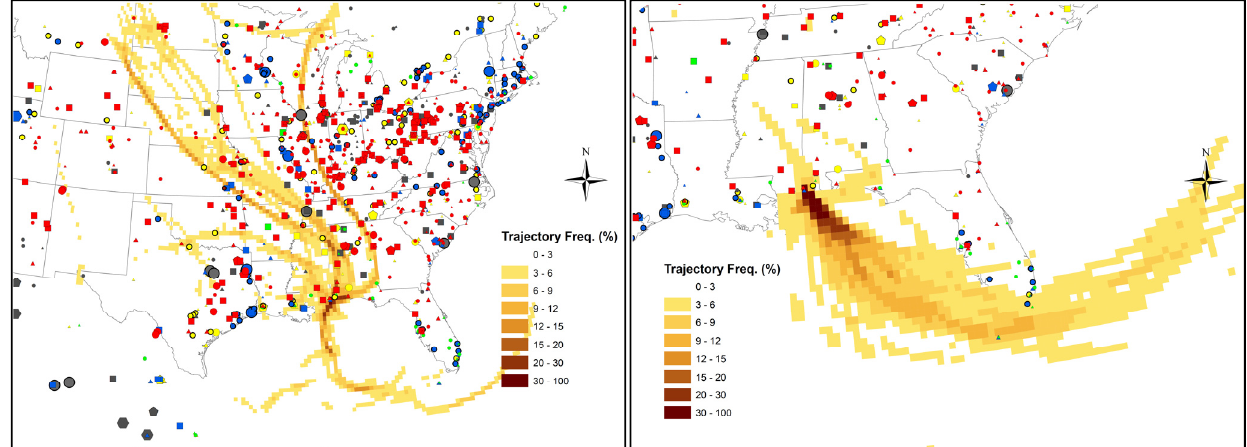
Figure 11. Back trajectory frequencies of high GOM (>20 pg·m − 3 , ( Left) ) and low GOM (<2 pg·m − 3 , ( Right) ) events during the spring 2011 intensive study. The color-coded trajectory frequency at each grid represents the percentage of trajectories passing through the gridded area. Symbols represent the major mercury emission sources with source types and strengths as the same as in Figure